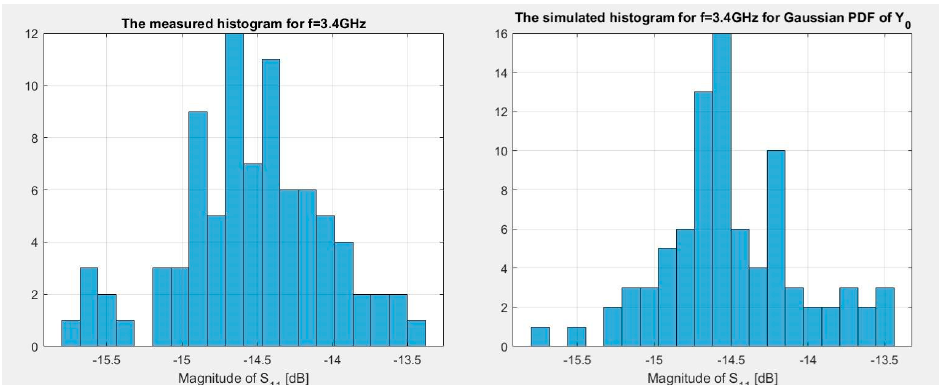
Figure 5. Histogram of | S 11 | obtained from the measurements and simulation results for σ y0 = 0.025 mm for antenna design from Figure 1.